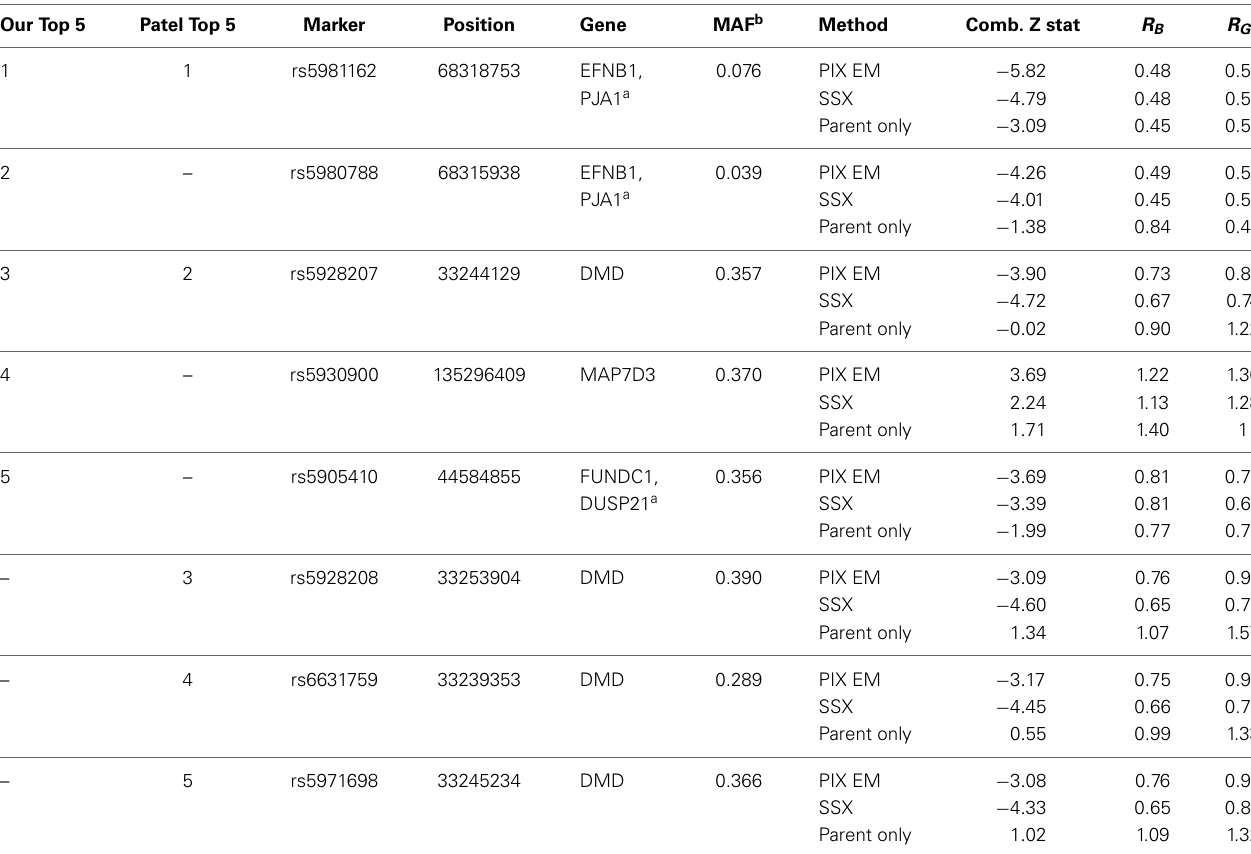
Table 8 | Top 5 CL/P SNPs from our PIX-LRT analysis and from Patel et al. (2013). Our Top